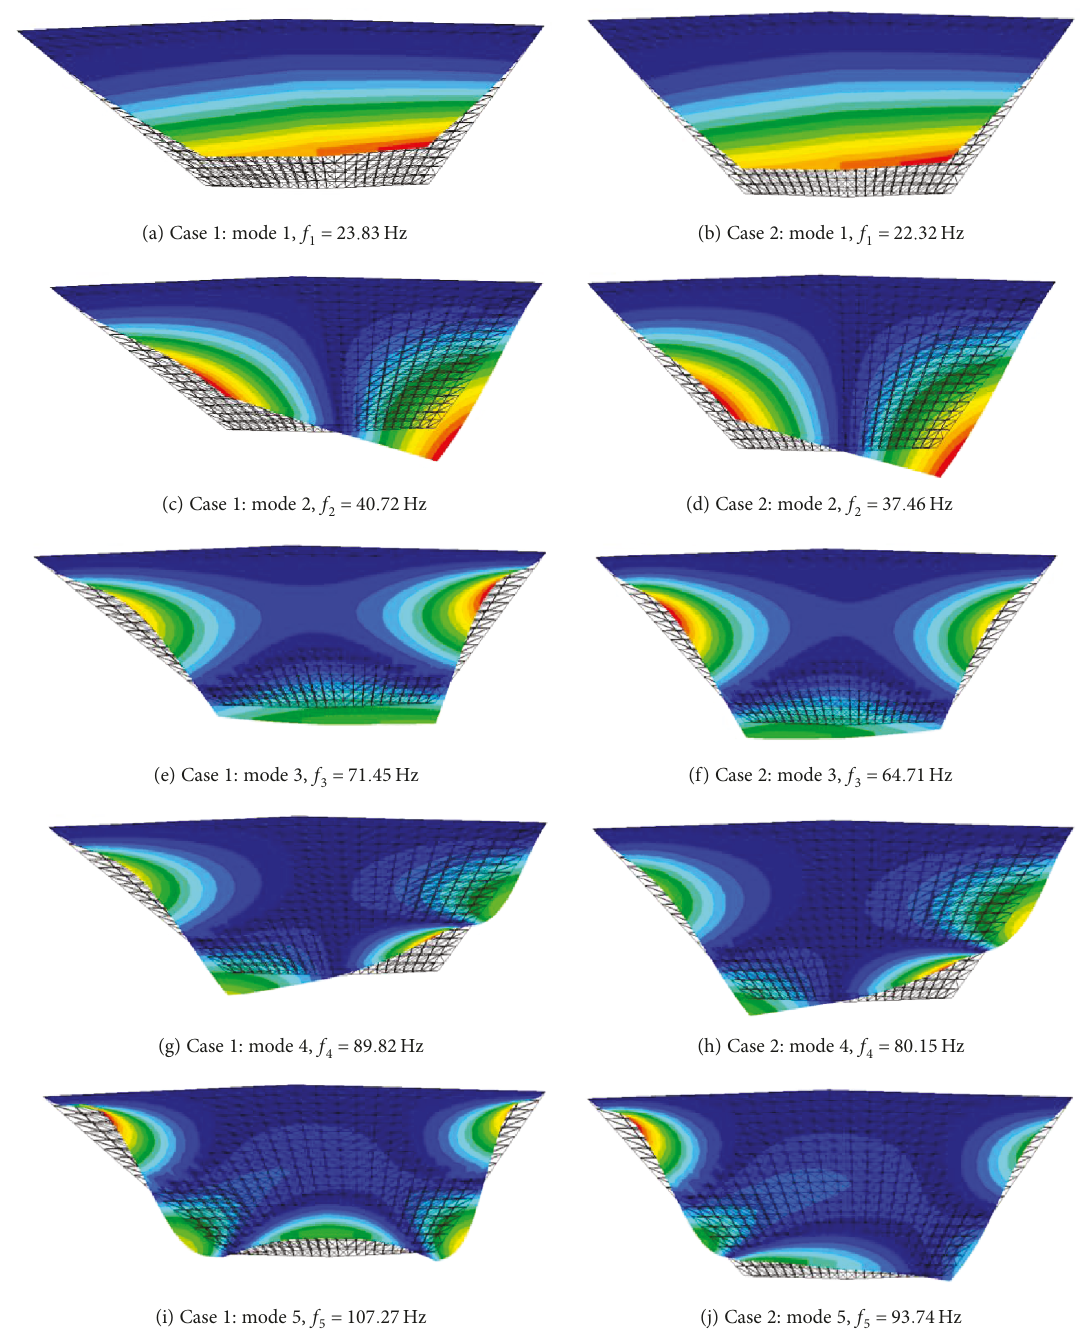
Figure 8: The fi rst six vibration modes and frequencies of the wing, (1) case 1: without the thermal e ff ects, (2) case 2: with the thermal e ff